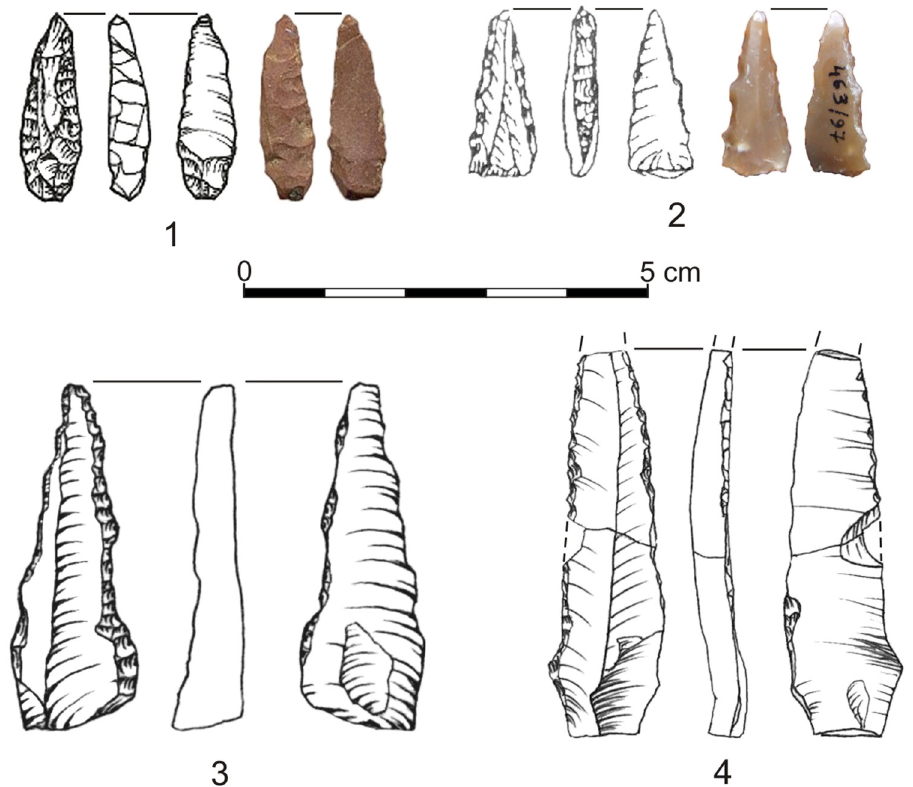
Figure 8: LBK perforator of the conical type. ( 1 ) Czchów, com. loco, site 10; ( 2 ) Gwo ź dziec, com. Zakliczyn, site 2; ( 3 ) Biesiadki, com. Gnojnik, site 16; ( 4 ) Ż erków, com. Gnojnik, site 1. 1 – Pieniny red radiolarite and 2 – 4 – Cracow Jurassic fl